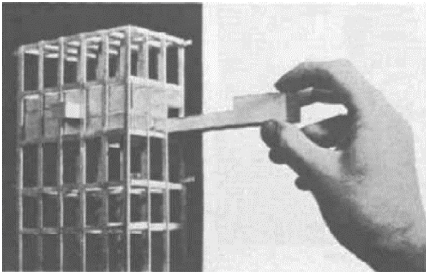
Figure 3: Le Corbusier: drawer-type residence (source: